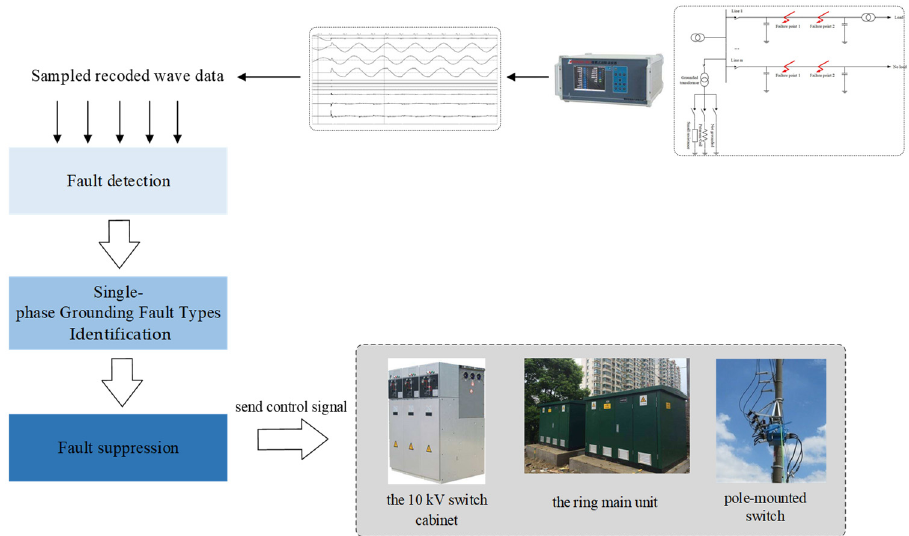
Figure 2. Diagnosis flow chart of single-phase grounding fault.